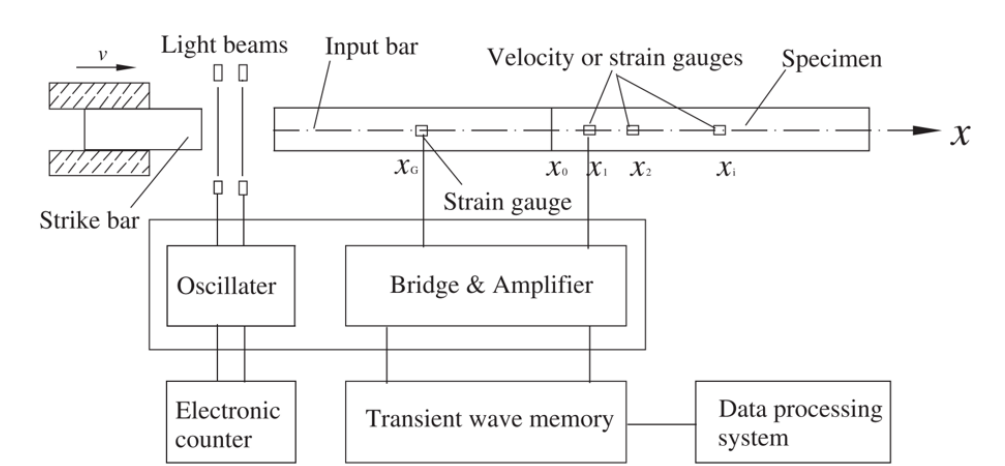
Figure 1. Schematics illustrating Wang et al. [21]’s method which combines Lagrangian analysis with Hopkinson pressure bar